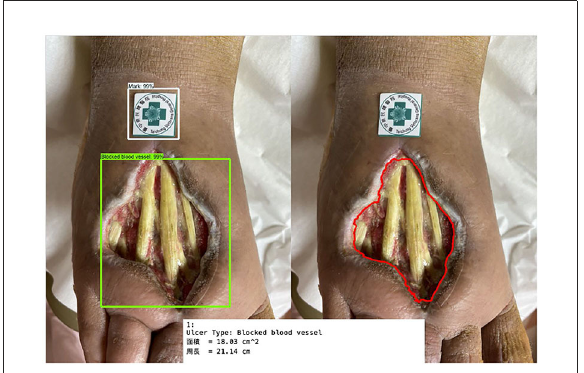
FIGURE13 Wound contour identification for the ulcer type is not included in our learning process.